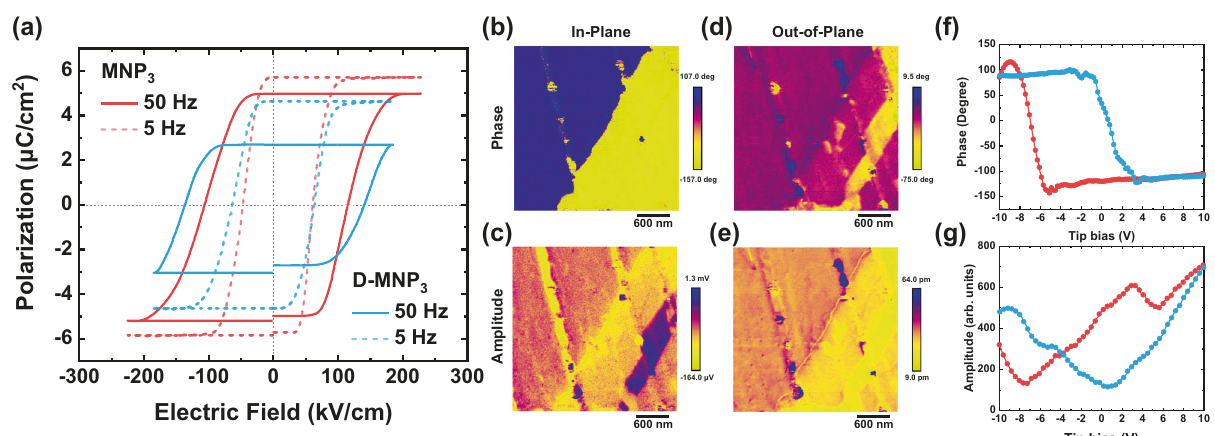
Fig. 4 Polarization-electric fi eld ( P - E ) loop and ferroelectric domains. a P - E loop of MNP 3 and D-MNP 3 at 50, and 5 Hz. PFM phase images of b in-plane and d out-of-plane polarization. PFM amplitude images of c in-plane and e out-of-plane polarization. PFM phase ( f ) and amplitude ( g ) switching curve